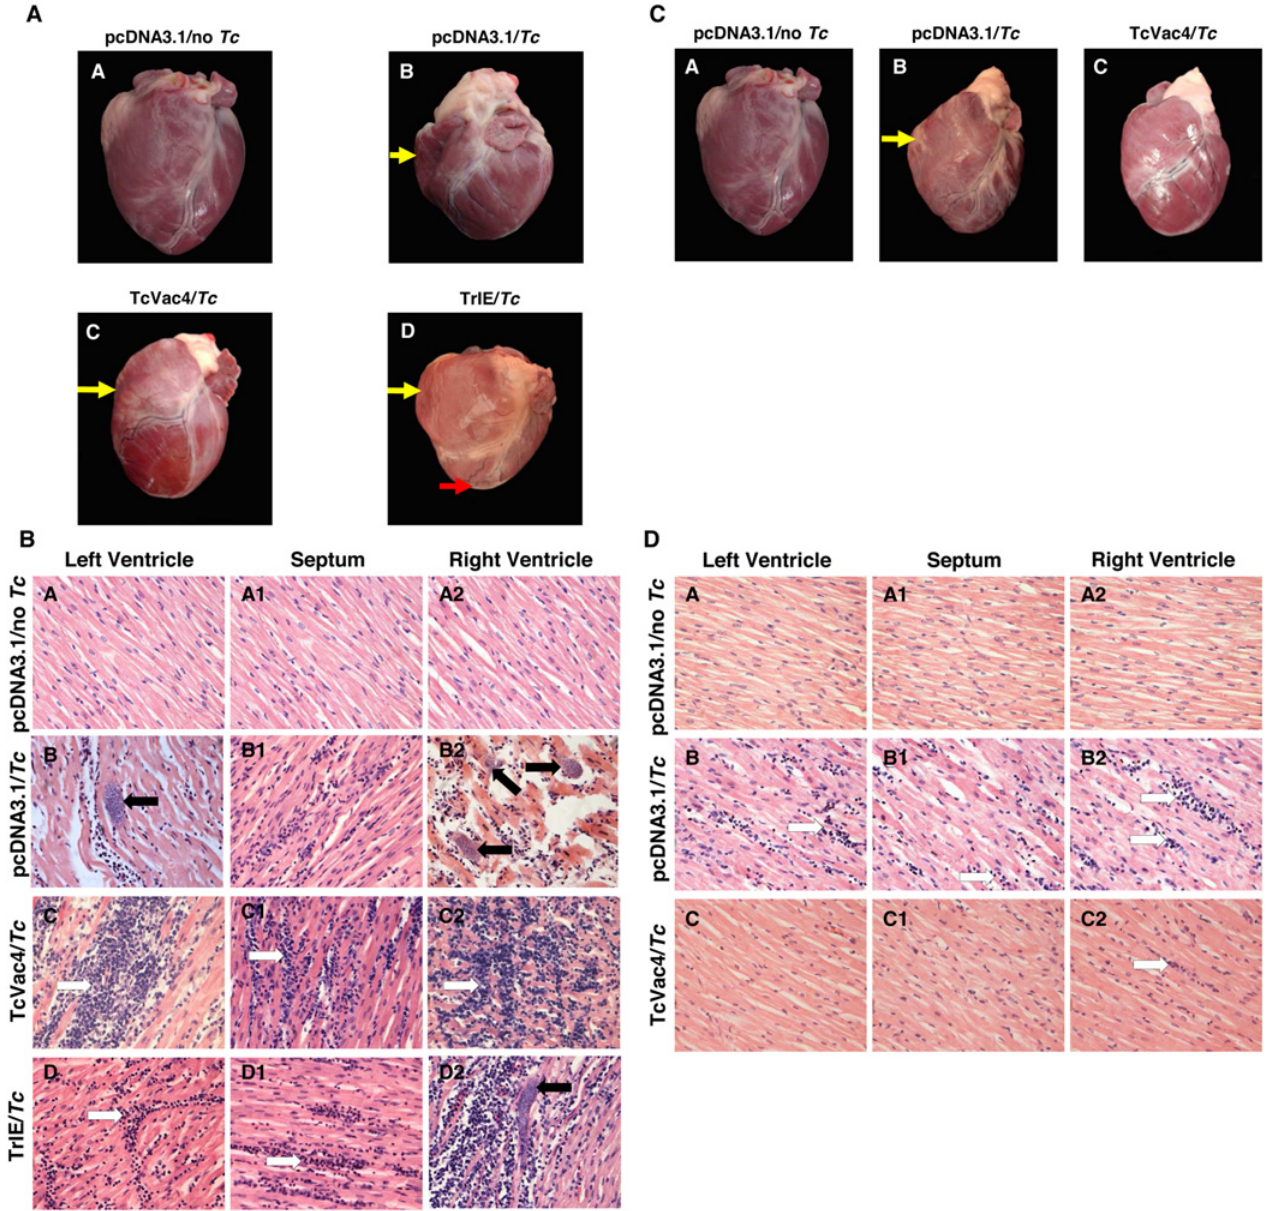
Fig 3. Macroscopic and microscopic alterations in the heart of T . cruzi -infected dogs ( ± TcVac4). (A) Morphologic alterations of heart in acute infection phase ( ± TcVac4). Shown are representative heart pictures from dogs included in pcDNA3.1/no Tc (A), pcDNA3.1/ Tc (B), TcVac4/ Tc (C) and TrIE/ Tc (D) groups, harvested at day 60 pi. Yellow arrows indicate right ventricular dilation. Red arrows indicate the pale/striated areas of fibrotic tissue. (B) Histological analysis of heart tissue-sections in acutely-infected dogs ( ± TcVac4). Heart tissue sections (5- μ M) from left ventricle, septum, and right ventricle were obtained at 60 days pi, and stained with hematoxylin-eosin. Shown are representative micrographs of heart from dogs injected with pcDNA3.1/ Tc (B, B1, B2), TcVac4/ Tc (C, C1, C2), and TrIE/ Tc (D, D1, D2). Micrographs from pcDNA3.1/no Tc (A, A1, A2) are shown as negative controls. Black arrows show amastigotes nests. White arrows show inflammatory infiltrate in the myocardium. (C) Morphologic alterations of heart in chronic disease phase ( ± TcVac4). Shown are representative heart pictures from dogs included in pcDNA3.1/no Tc (A), pcDNA3.1/ Tc (B), TcVac4/ Tc (C) and TrIE/ Tc (D) groups, harvested at day 365 pi. Black arrows point out the right ventricular dilation. (D) Histological analysis of heart tissue-sections in chronically-infected dogs ( ± TcVac4). Heart tissue sections (5- μ m) from left ventricle, septum, and right ventricle were obtained at 365 days pi, and stained with hematoxylin-eosin. Shown are representative micrographs of chronically-infected dogs injected with pcDNA3.1 only (B, B1, B2) or immunized with TcVac4 (C, C1, C2). Micrographs from pcDNA3.1/no Tc , i.e. normal/healthy controls (A, A1, A2) are shown for comparison. White arrows mark infiltrating inflammatory cells in myocardium.